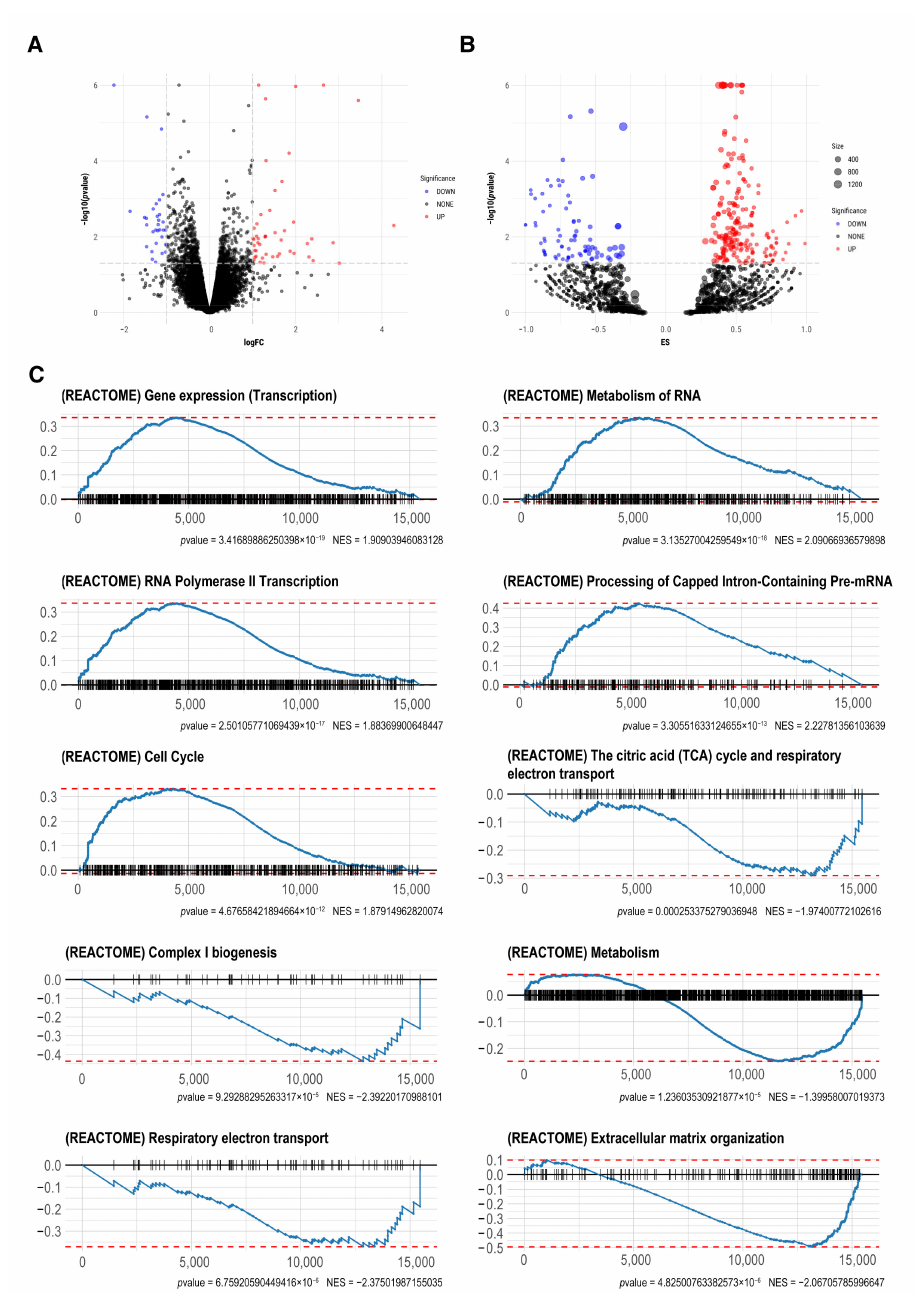
Figure 2. Differential gene expression analysis and GSEA. ( A ) Volcano plot of differentially expressed genes (DEGs). Red represents upregulated genes, blue represents downregulated genes, and black represents genes with no significant change in expression. ( B ) Volcano plot of gene set enrichment analysis (GSEA) based on the Reactome database. Red represents pathways mainly composed of upregulated genes, blue represents pathways mainly composed of downregulated genes, and black represents pathways with no significant change in gene expression. The size of dots represents the count of genes in each pathway. For visualization purposes, − log10 ( p -value) greater than 6 was defined as equal to 6. ( C ) Enrichment plots for top five upregulated and downregulated pathways based on the p